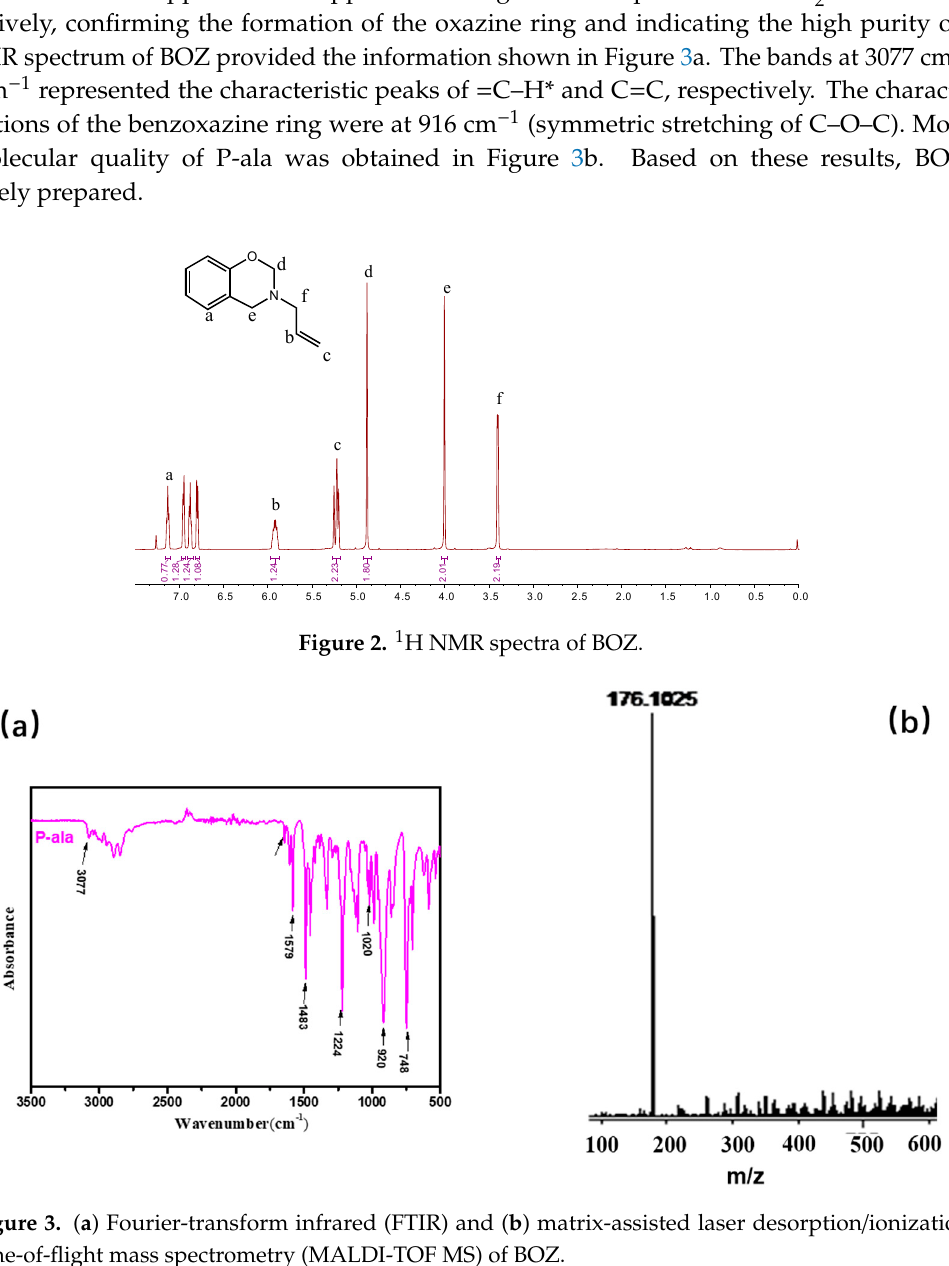
Figure 3. ( a ) Fourier-transform infrared (FTIR) and ( b ) matrix-assisted laser desorption/ionization time-of-flight mass spectrometry (MALDI-TOF MS) of BOZ.